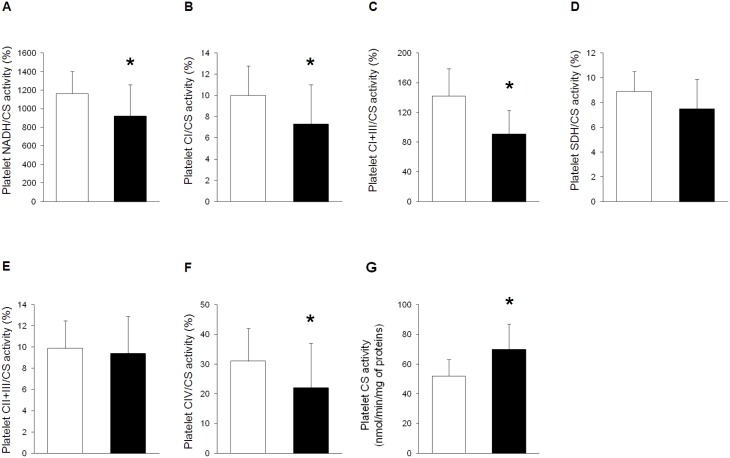
Platelet mitochondrial biochemistry during septic shock.Mitochondrial biochemistry was measured on platelets of ten surgical controls (white bars) and thirty patients with septic shock (<24 h from ICU admission) (black bars). Activities of nicotinamide adenine dinucleotide dehydrogenase (NADH) (p = 0.015#) (A), complex I (CI) (p = 0.018#) (B), complex I and III (CI+III) (p<0.001) (C), succinate dehydrogenase (SDH) (p = 0.086) (D), complex II and III (CII+III) (p = 0.672) (E) and complex IV (CIV) (p = 0.012#) (F) are expressed as percentages of citrate synthase (CS) activity (p = 0.002) (G). Data are reported as means and standard deviations. *p<0.05 vs. controls [Student’s t or (#) Wilcoxon rank sum tests]. Platelet count (182±83 vs. 176±63 *103/mm3) did not differ between groups (p = 0.901).